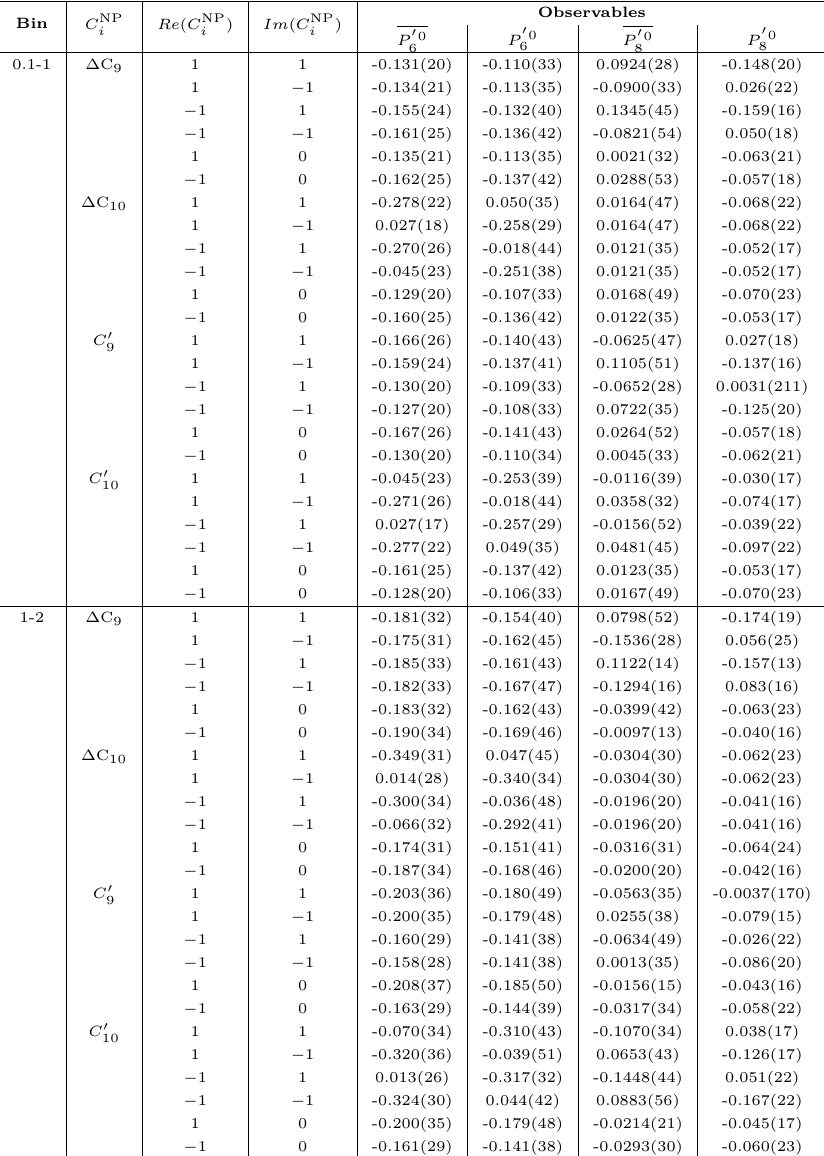
¯ B 0 → ρ 0 ll and C 0 for the q 2 9 , 10 9 , 10